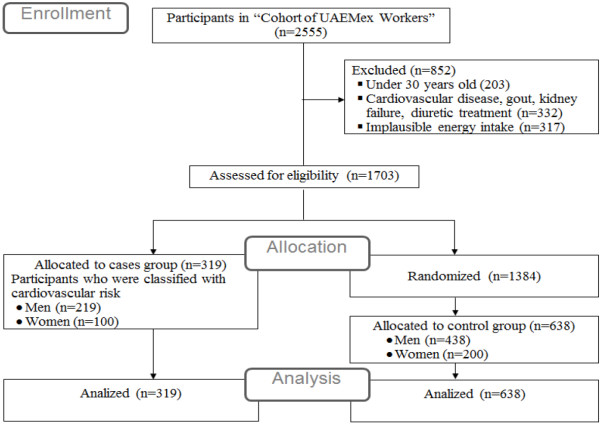
Flow diagram of eligibility and allocation of participants in “Cohort of UAEMex Workers”.